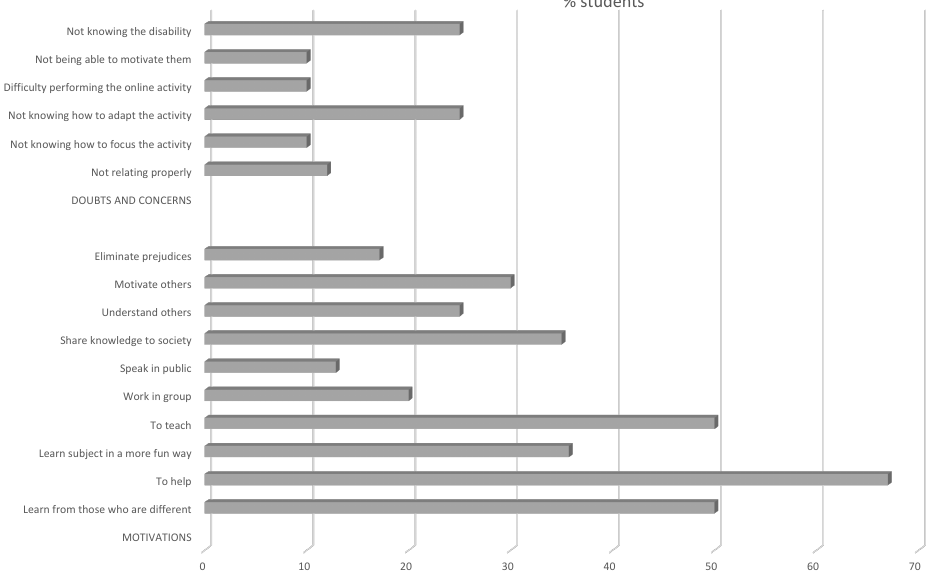
Figure 4. Doubts, concerns, and motivations of students before SL